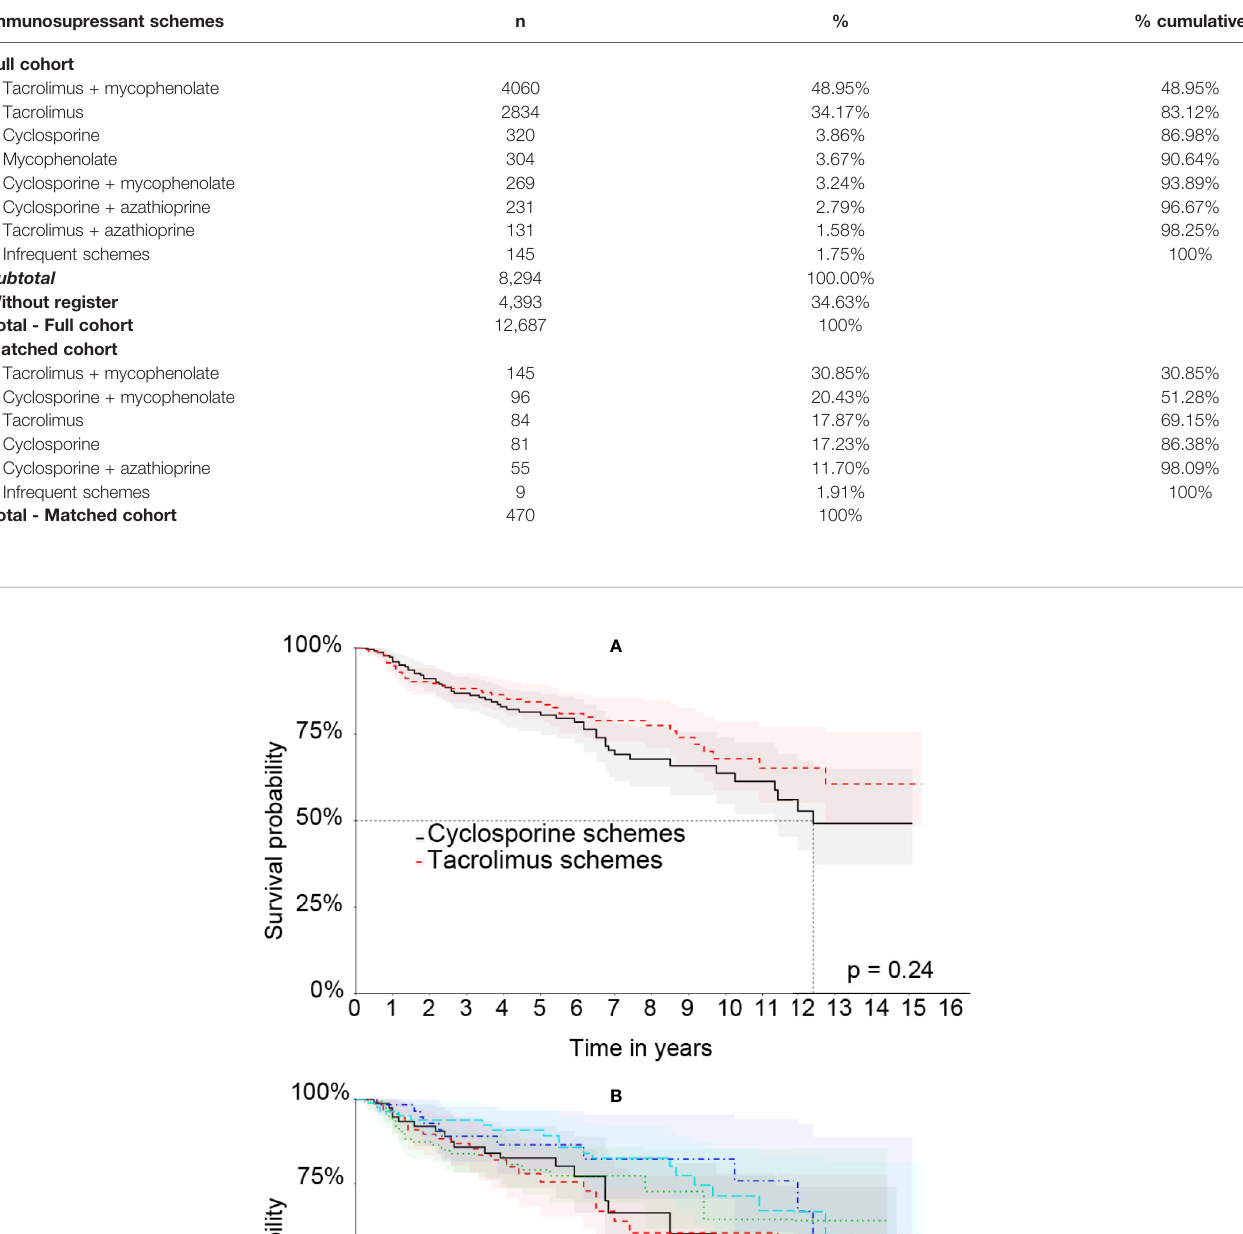
TABLE 2 | Full and Matched cohort immunosuppression therapy